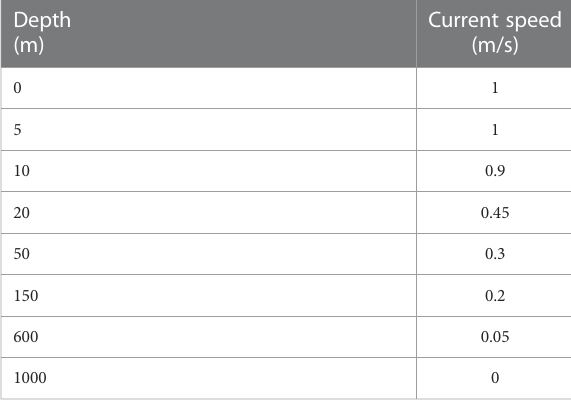
TABLE 4 Current pro fi